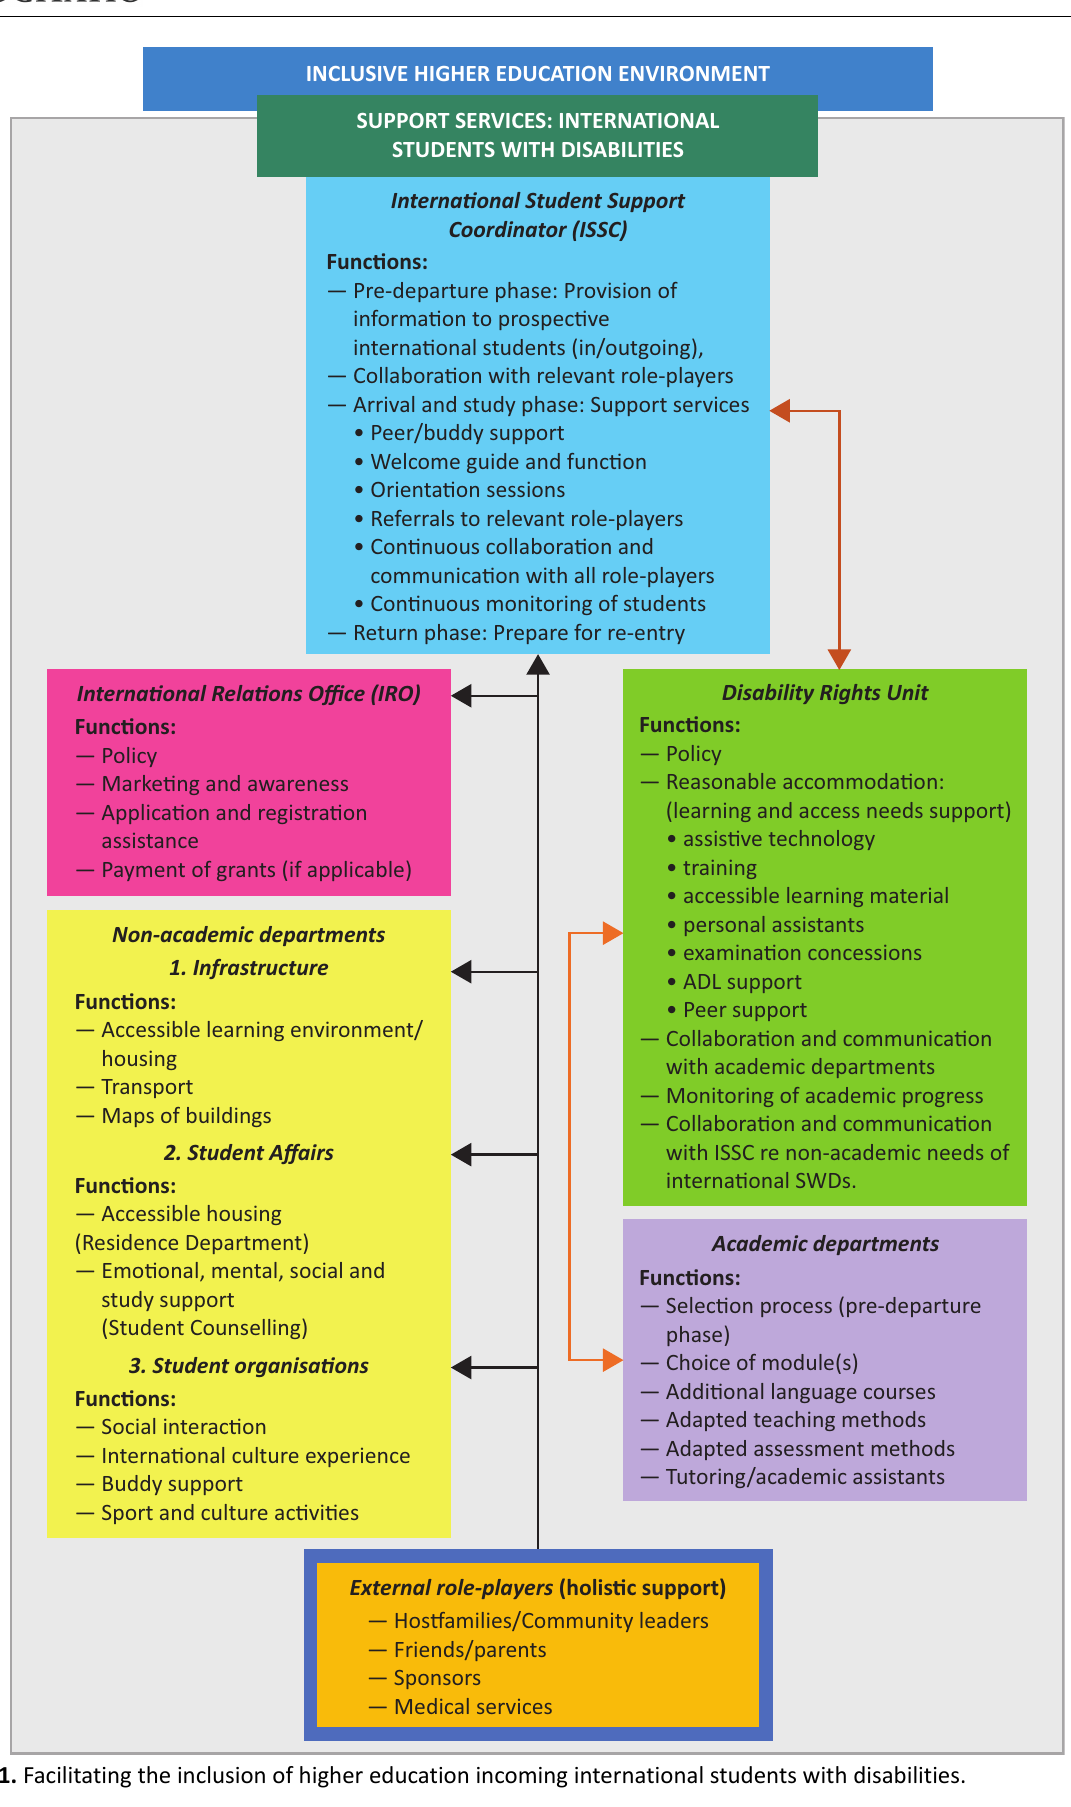
Figure 1. Facilitating the inclusion of higher education incoming international students with